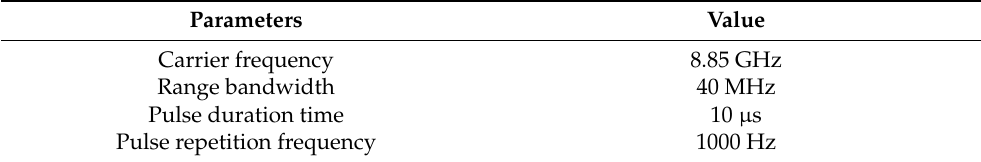
Table 3. Main radar parameters for X-band SAR system.